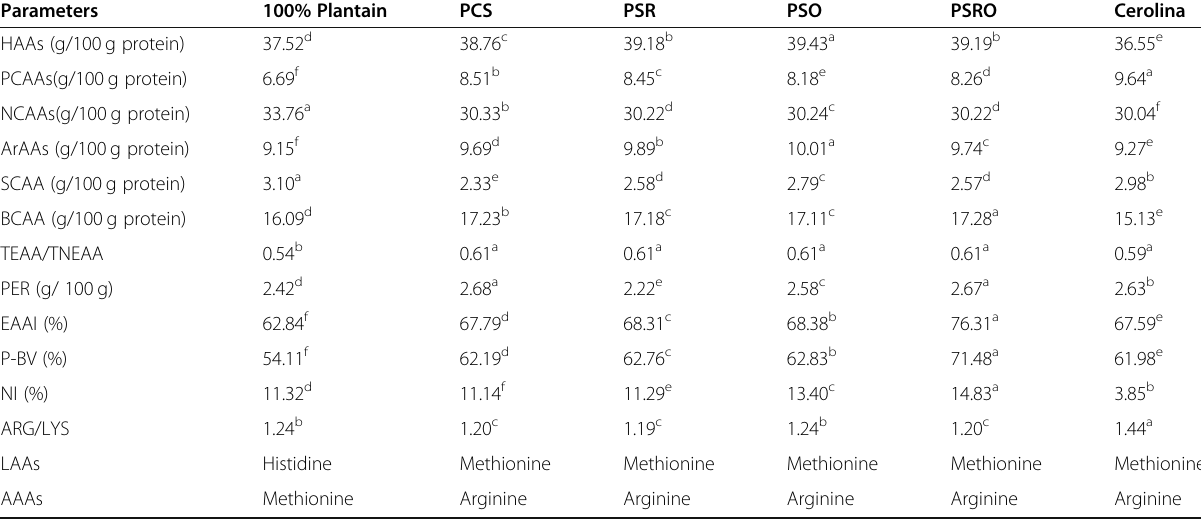
Means (±SEM) with different alphabetical superscripts in the same column are significantly different at P <0.05 Key: 100% Plantain flour; PSC: Plantain: Soycake (70:30%); PSR: Plantain: Soycake: Rice bran (65:30:5%); PSO: Plantain: Soycake: Oat bran (65:30:5%); PSRO: Plantain: Soycake: Rice bran: Oat bran (60:30:5:5); Cerolina: a commercial flour meal. HAAs Hydrophobic amino acids, PCAAs Positively charged amino acids, NCAAs Negatively charged amino acids, ArAAs Aromatic amino acids, SAAs Sulphur containing amino acids, BCAAs Branch chain amino acids, EAAs Essential amino acids, NEAAs Non-essential amino acids, ARG/LYS Arginine/ lysine ratio, PER Protein efficiency ratio, P-BV Predicted biological value, NI Nitrogen index, LAAs Limiting Amino Acids, AAAs Abundant amino